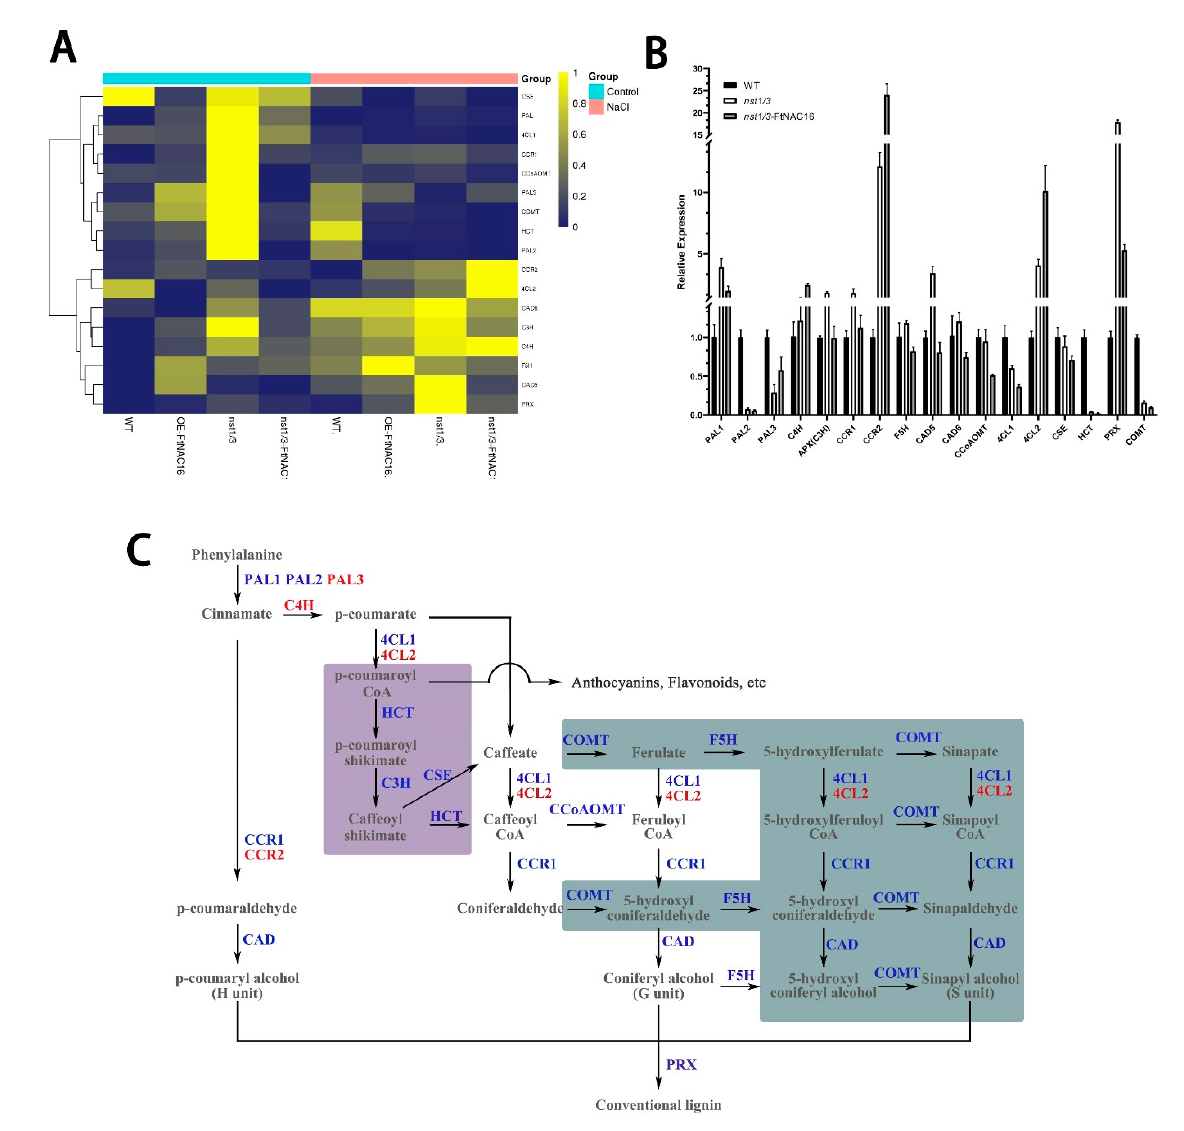
Figure 8. Expression of key enzyme genes in the lignin pathway after salt stress treatment. ( A ) Heat map of lignin pathway enzyme gene expression after salt stress treatment. Blue indicates upregulation, and yellow indicates downregulation. ( B ) Expression of lignin synthase genes in WT, nst1/3 and nst1/3 -FtNAC16 lines after salt stress; ( C ) Lignin synthesis pathway pattern. The blue text represents downregulated enzyme genes in nst1/3 -FtNAC16, and the red font represents upregulated genes compared to nst1/3 lines. The purple background and green background depict inhibited branches in nst1/3 and nst1/3 -FtNAC16 lines under salt stress (compared with WT).